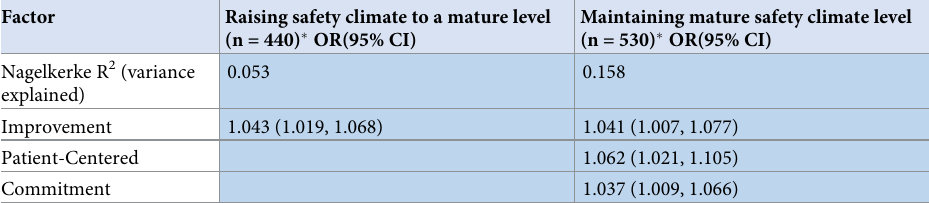
Commitment 1.037 (1.009, 1.066) Factors significant in at least one of the models are presented. � Adjusted for unit